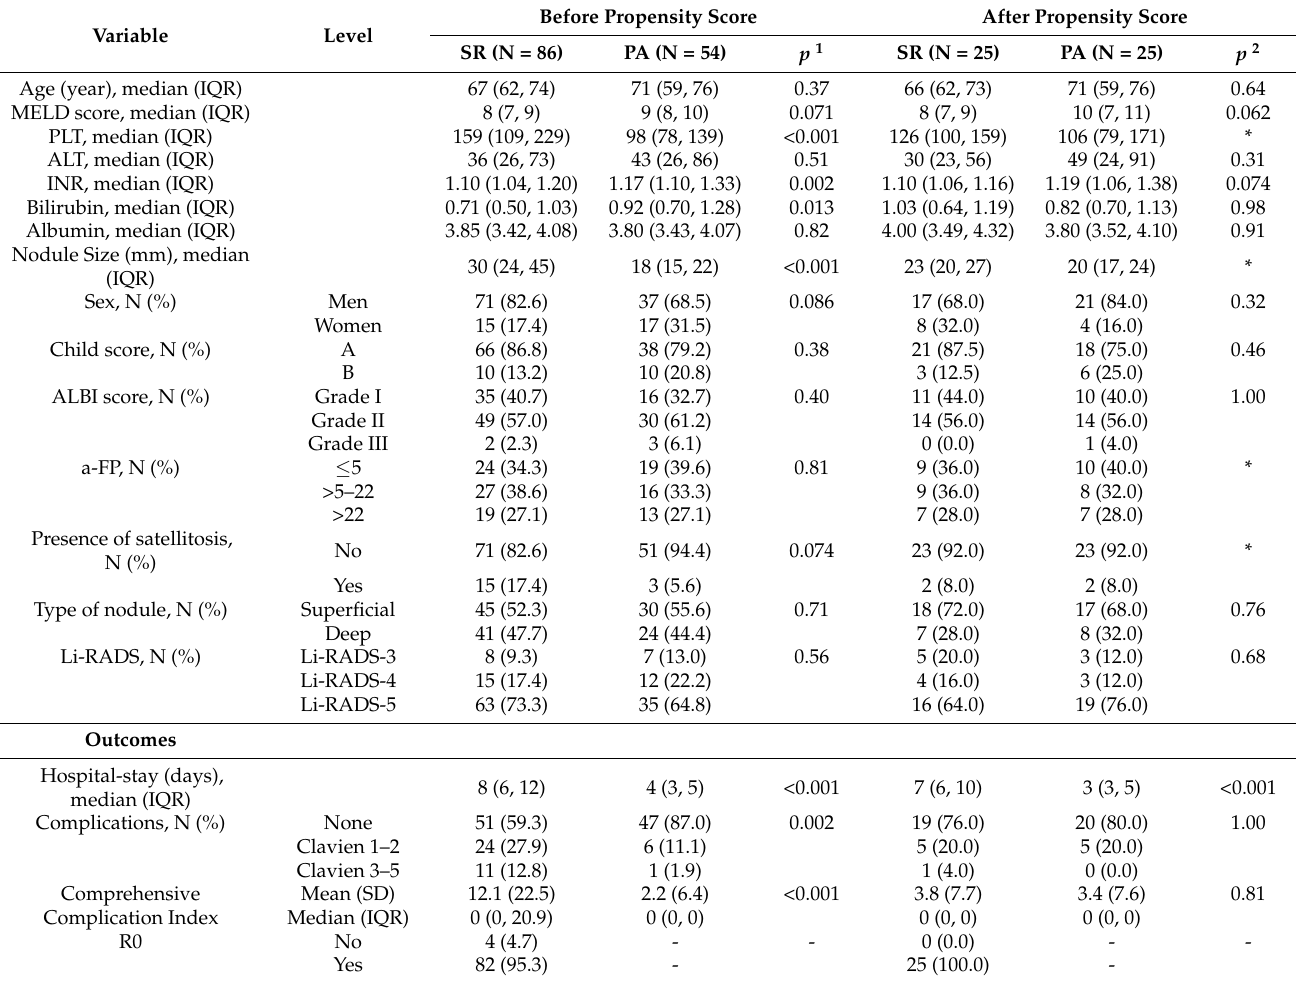
Table 1. Patients’ characteristics before (N = 140) and after (N = 50) propensity score, by type of